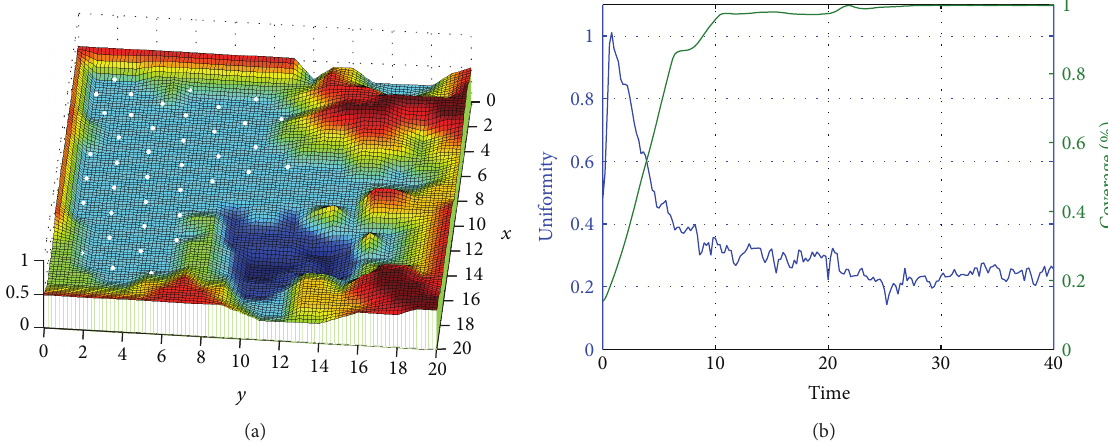
Figure 5: (a) Redeployment effect after the massif disappears and (b) network coverage rate and uniformity